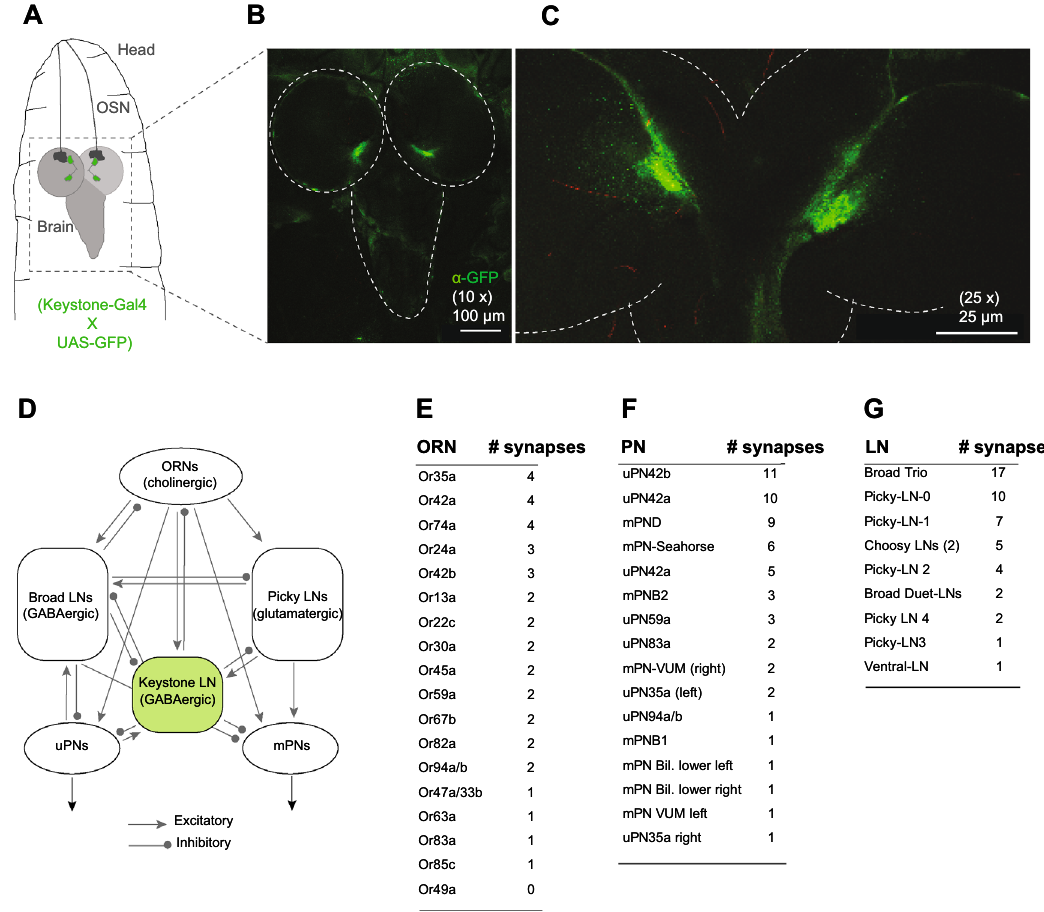
Figure 2. Keystone-LN is centrally positioned in the Drosophila larval antennal lobe. ( A ) Cartoon showing the anterior end of a third-instar Drosophila larva. Confocal images of the larval brain were taken with a 10 × objective (scale bar is 100 µm) ( B ) and a 25 × objective (scale bar is 25 µm) ( C ). Anti-eGFP antibody stains a single pair of neurons in the two anterior brain lobes ( B , C ) and none in the ventral nerve cord ( B ). ( D ) Peripheral olfactory circuit of the Drosophila larva. Excitatory and inhibitory connections between Keystone-LN, OSNs, Broad and Picky LNs, uPNs, and mPNs are shown. Adapted from 7 . ( E – G ) The number of synapses between Keystone-LN and different classes of neurons is tabulated for ( E ) OSNs, ( F ) PNs, and ( G )